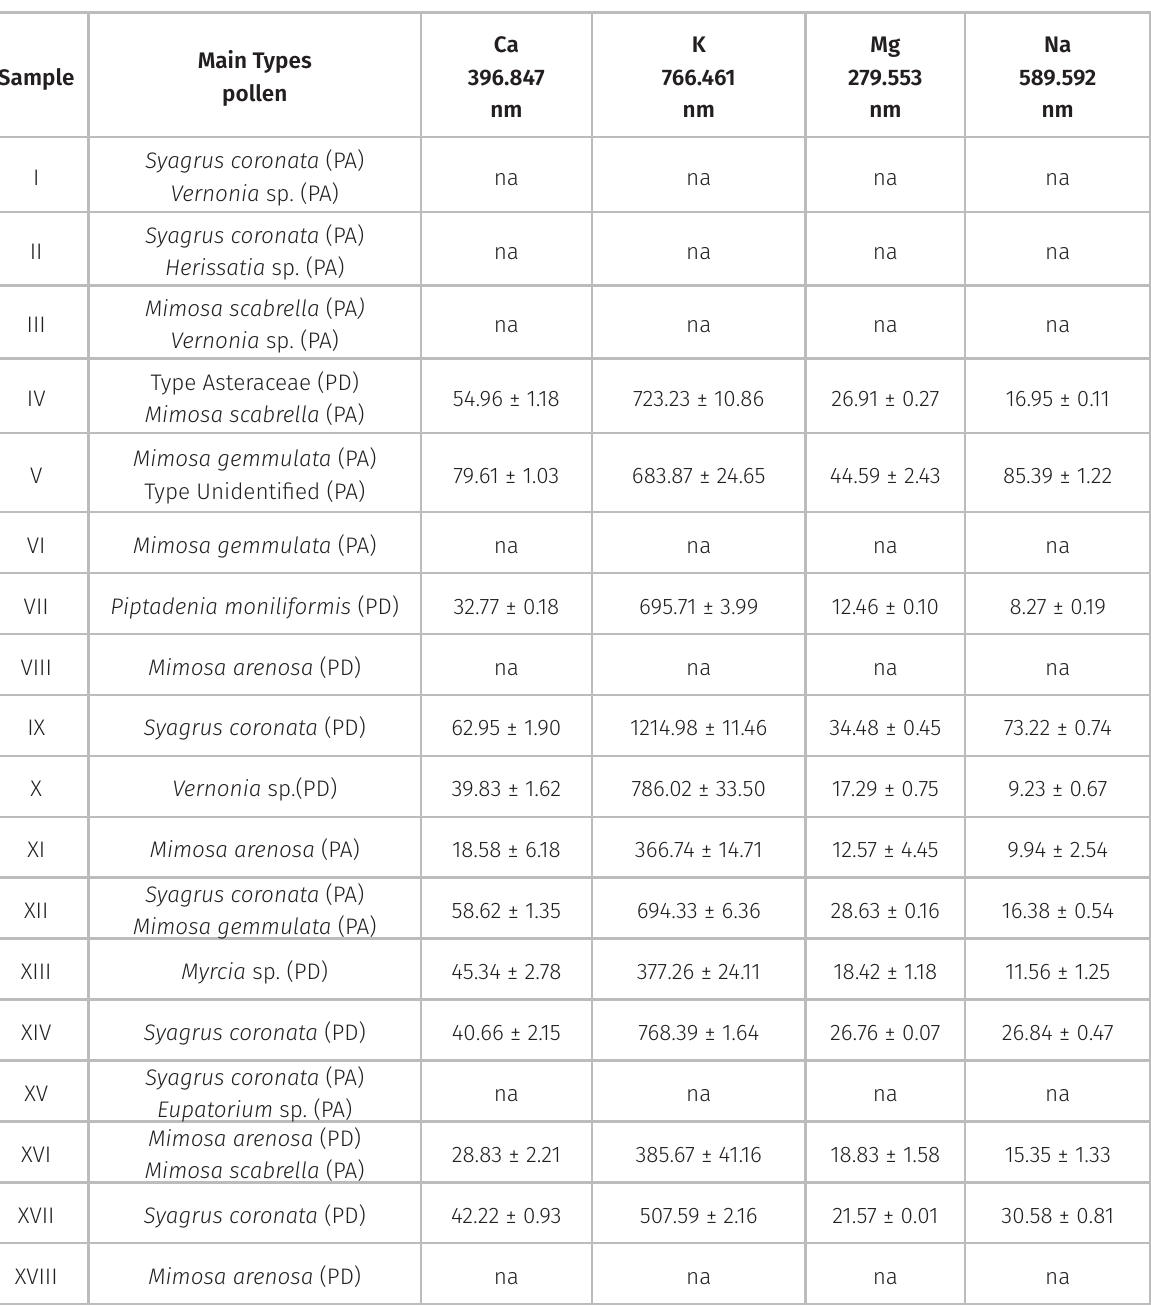
Table V. Composition of macronutrients (Ca, K, Mg and Na) in honey samples marketed in municipalities of Paraguaçu River/Bahia region (mg Kg -1